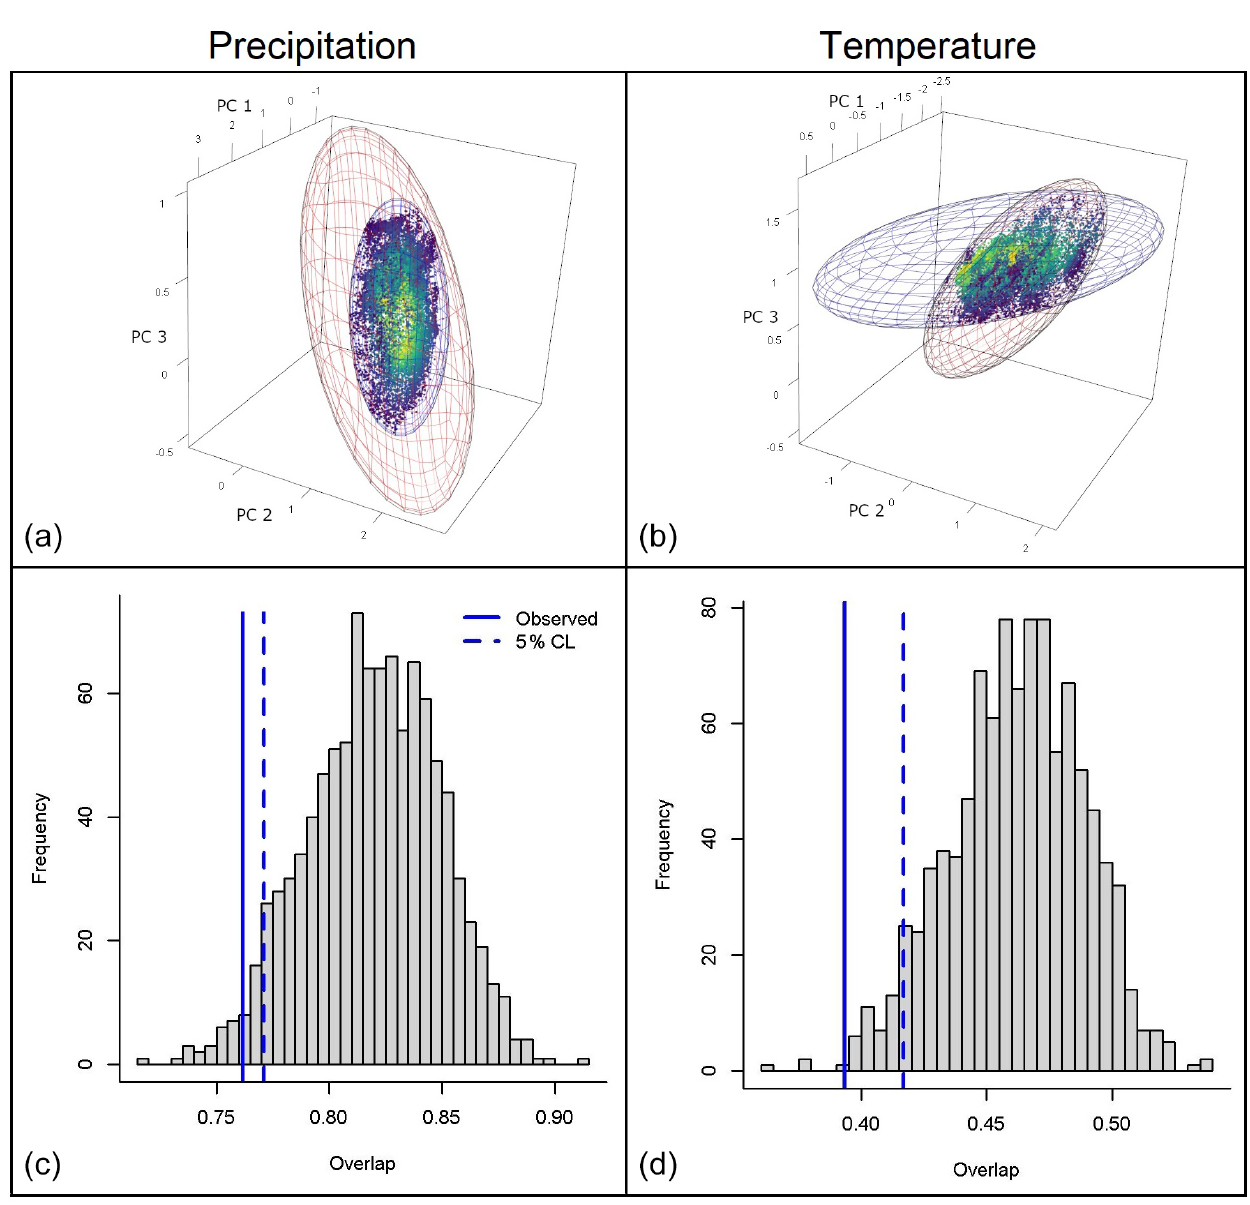
Figure 4. (a, b) Species niche overlap based on ellipsoid envelope models (background overlap). Blue and red ellipsoids represent ecological niches of D. marginatus and D. reticulatus , respectively. Warmer colors indicate conditions that are closer to the centroid of D. marginatus . (c, d) Comparison of observed values of niche overlap against the null distribution of 1000 overlap values of random ellipsoids. Solid blue lines show observed values. Dashed blue lines show the 5% confidence